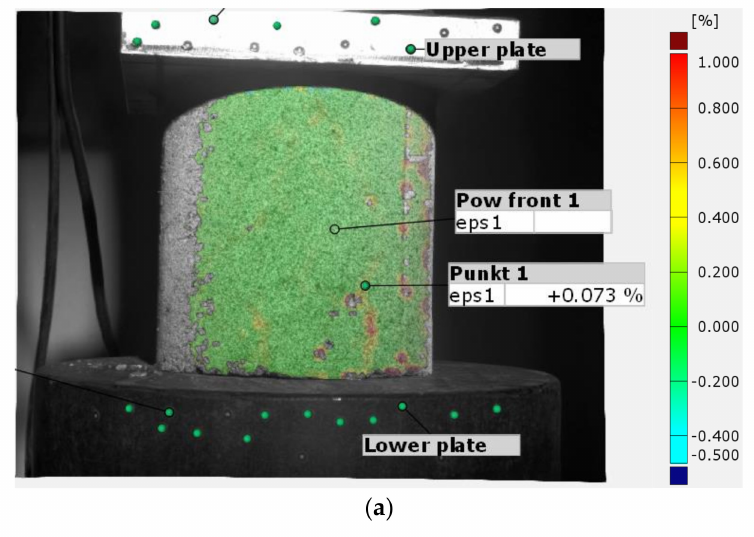
Figure 9. Image of the major strains of the specimen surface at the peak load of the first test cycle. Point strain inspection (Figure 10), performed on the basis of the strain distribution on the specimen surface, allows for accurate characterization of the influence of local phenomena on the work of the entire test specimen. This is particularly important in the case of composite materials, where local contact issues between individual components of the composite will determine its global